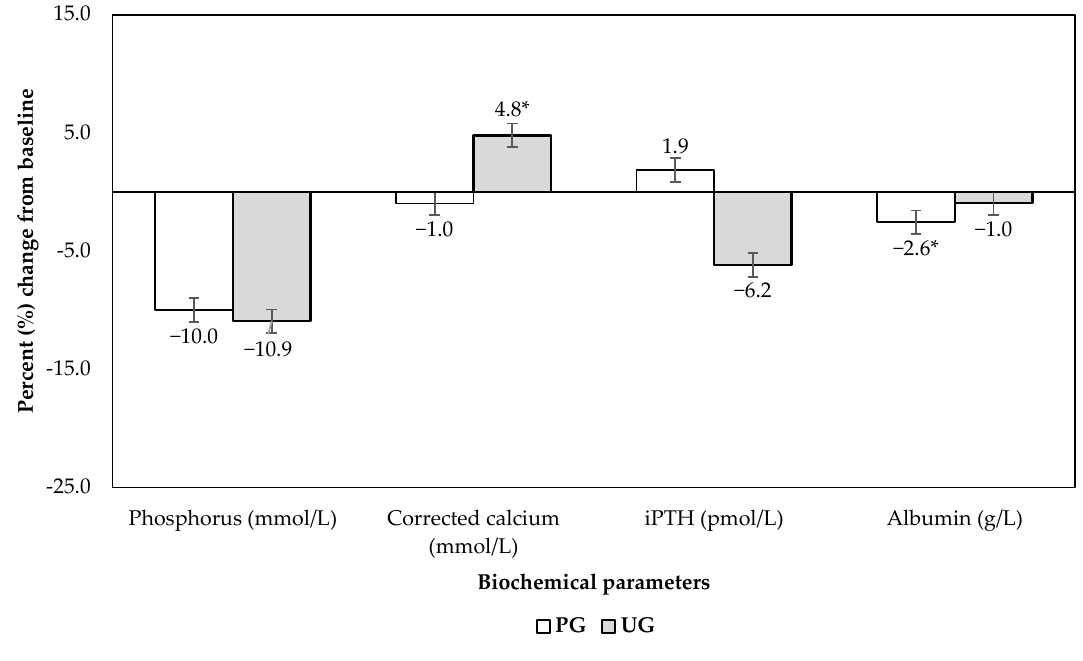
Figure 2. Percent change in biochemical parameters from baseline. * p < 0.05. Abbreviation: PG, PMA group; iPTH, intact parathyroid hormone; UG, usual care group.